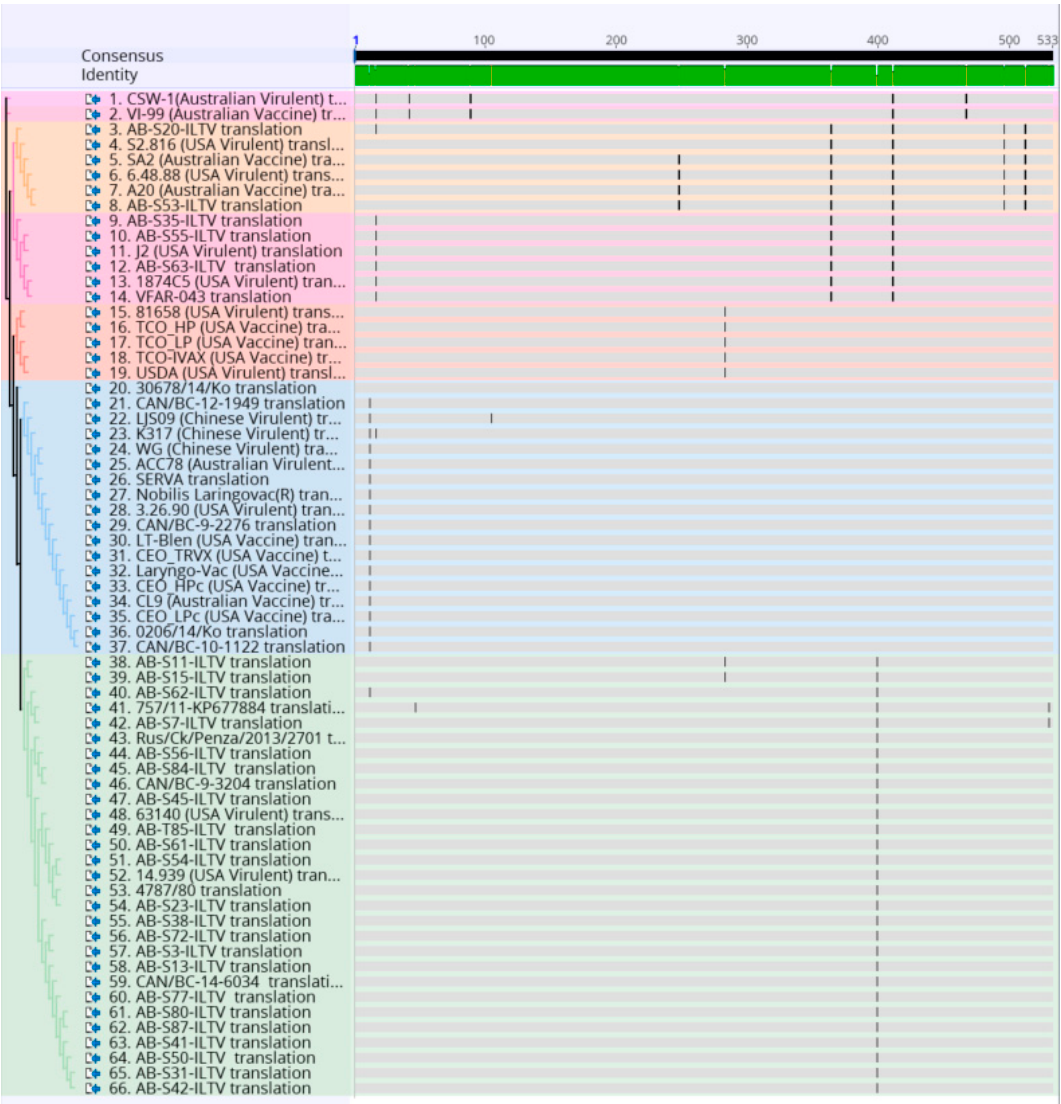
Figure 3. Alignment of the amino acid sequence of 32 Canadian ILTV strains and 36 ILTV reference strains using MUSCLE and Geneious software package. Vertical lines indicate nucleotide change positions. Samples are color-coded as the phylogenetic tree. The nucleotide sequences were uploaded to the GenBank (accession numbers are in Table 1).